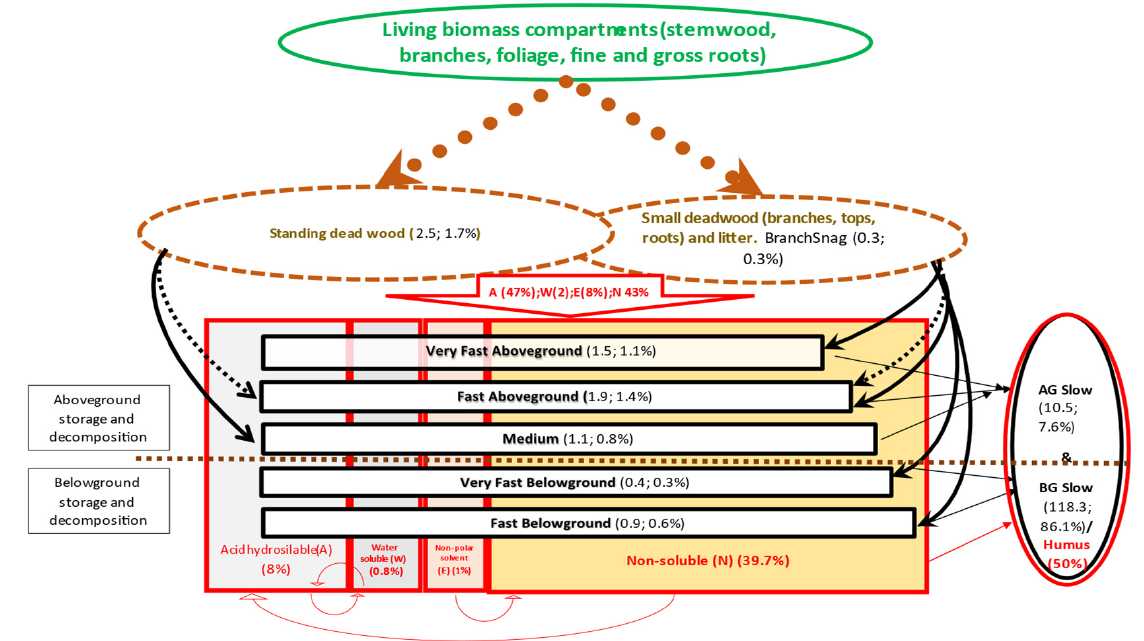
Figure 1. Overview of the conceptual frameworks and approximation of C stocks and flows for CBM and Yasso15. Note: Solid flows of carbon are only shown on the graphs (i.e., fluxes are not shown): biomass accumulation (in green) and transfers from living biomass to dead organic matter of the soils (in brown). C pools (as horizontal and vertical blocks) and transfers among them are shown in black for CBM and in red for Yasso15. Horizontal black blocks correspond to CBM C pools, while red vertical ones to Yasso15 soil C pools. Horizontal dotted line imitates the aboveground and belowground processes. Decay of fresh dead organic matter (continuous arrows) and physical transfers (dotted arrows) are shown. Thin arrows show transfers among the soils C subpools (to humus). C stock in living biomass (137.5 tC/ha, ABG 83.8%, BGB 16.1%). Living biomass turnover rates (% of standing stock): branches 2.7% softwood and 2.5% hardwood, coarse roots (stumps) 2%, fine roots 64.1% and for foliage 25% for softwood and 95% for hardwood species (excluding mineral components of biomass). Annual input to dead organic matter is shared between dead wood (DW, 8.1%) and litter (LT, 91.9%), annual transfer rate from standing DW to laying DW (8.8%). From total annual DW input, 40% is represented by stem wood and 60% by branches. C stocks are presented for each subpool in tC ha − 1 and in % as of total C stock in dead organic matter (100%). Values are estimated as average over simulated period in the BAU scenario. Pools and transfers are shown according to Kurz et al. [35] and Pilli et al. [33] for CBM and Tuomi et al. [45] for Yasso15.